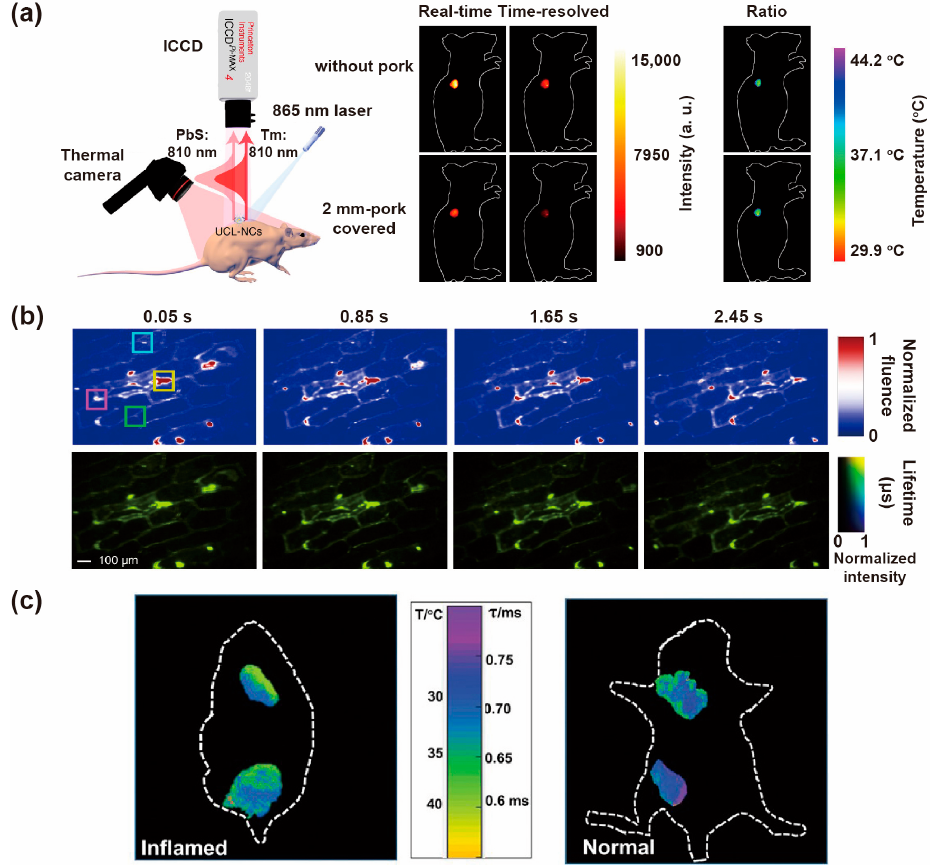
Figure 12. ( a ) Diagram of surficial and intratumoral detection in vivo and corresponding real-time, time-resolved and ratio UCL imaging without and with a 2 mm-pork slice covering under 865 nm excitation. Reproduced with permission from [89]. Copyright 2020, Nature Publishing Group. ( b ) The time-integrated images of a dynamic onion epidermis cell sample with labeling UCNPs. Repro- duced with permission from [90]. Copyright 2021, Nature Publishing Group. ( c ) Thermographic lifetime imaging of the nanosensors in the inflamed and normal mouse, showing the precise position of temperature distribution. Reproduced with permission from [66]. Copyright 2020,